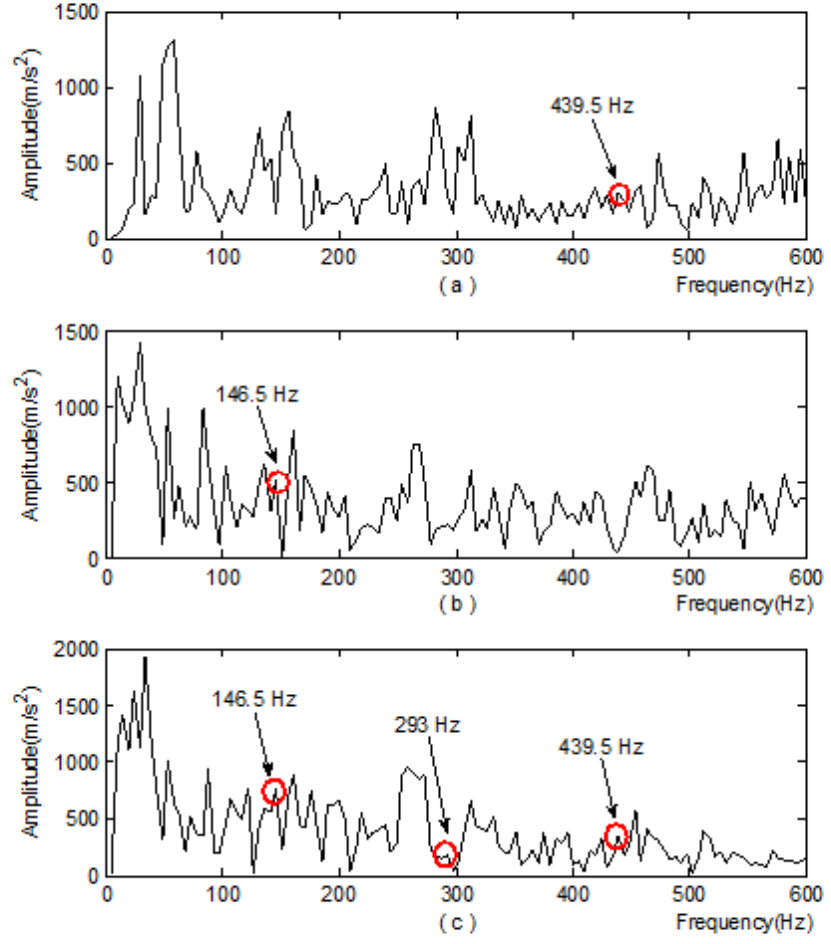
Figure 9. Comparative analysis on feature extraction of vibration acceleration signals at the measurement points ( a ) Local spectrum; ( b ) Demon spectra; ( c ) Demon spectra of signal obtained from adaptive redundant lifting and single branch reconstruction of the